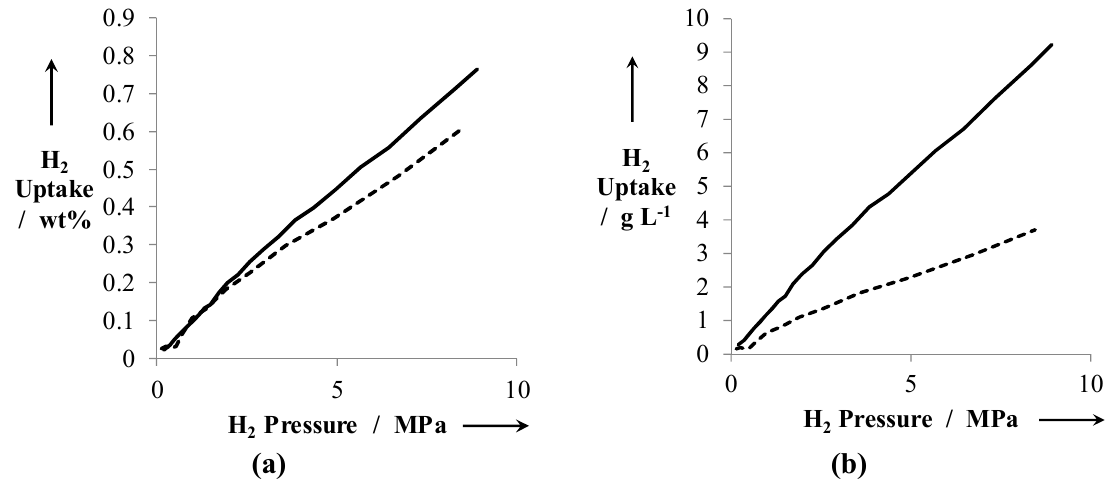
Figure 4. Hydrogen uptake properties of synthesized Cu at 293 K, 10 MPa; ( b ) Volumetric uptake at 293 K, 10 MPa. Values for IRMOF-1 are shown for comparison (dashed